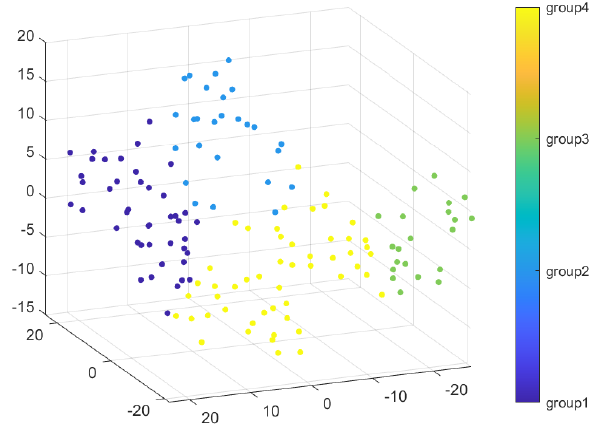
Figure 5. Cluster visualization for four groups.